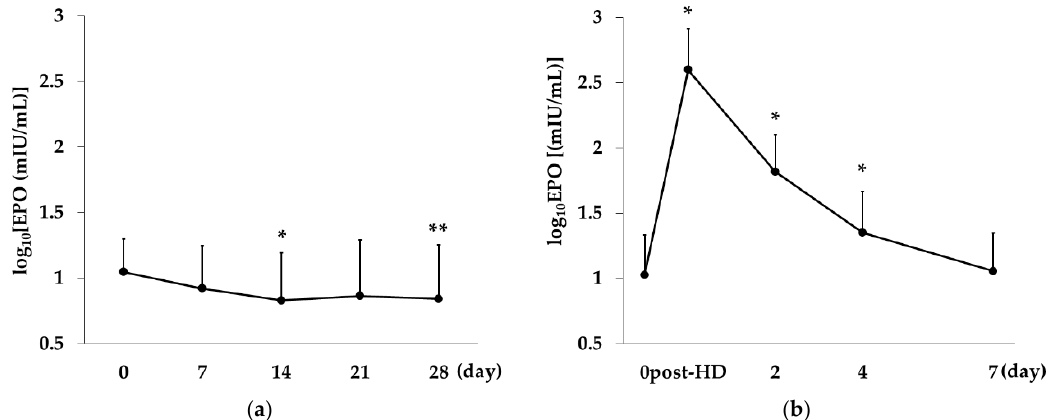
Figure 1. Change over time in erythropoietin concentration in the Rox and the DA group. ( a ) In the Rox group, log 10 (EPO concentration) showed significant decreases on Day 14 ( p < 0.01 vs. Day 0) and Day 28 ( p = 0.047 vs. Day 0). ( b ) In the DA group, EPO concentration increased sharply immediately after DA administration and then gradually declined, returning to baseline on Day 7. One-way repeated measures analysis of variance and Bonferrroni’s multiple comparison were performed for post-hoc tests. The data are represented as mean ± SD. * p < 0.01, ** p < 0.05.